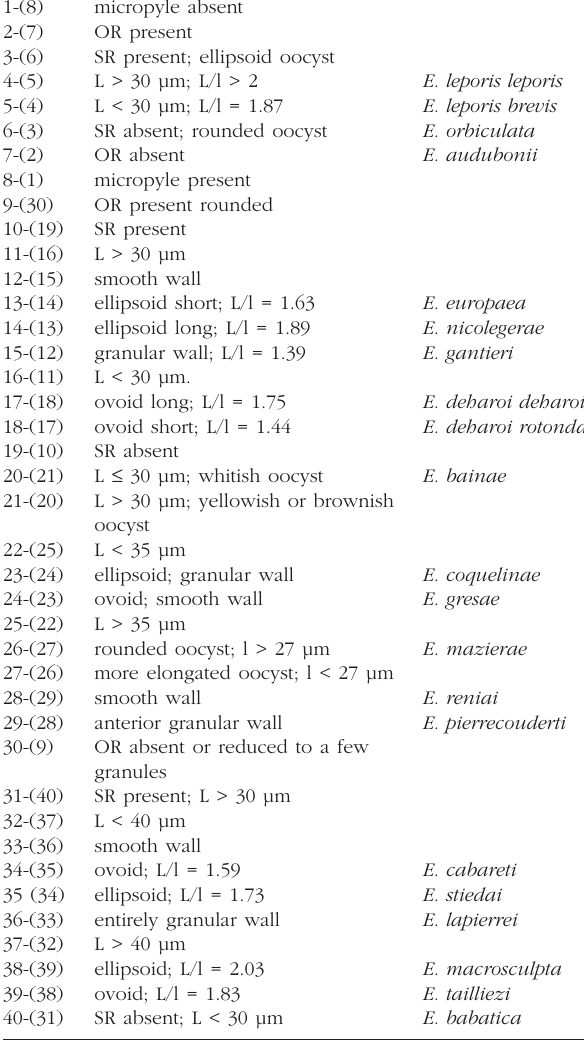
Table I. – Keys for identification; L = length; l =